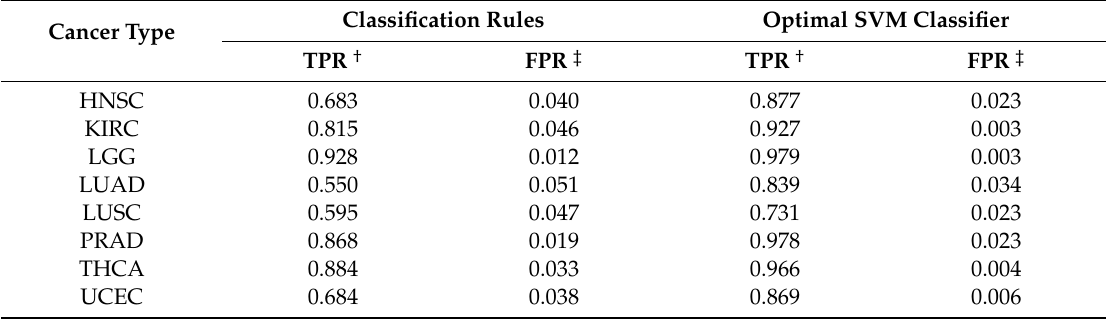
Table 1. Results of 10-fold cross-validation by using 69 produced classification rules and the optimal support vector machine (SVM)